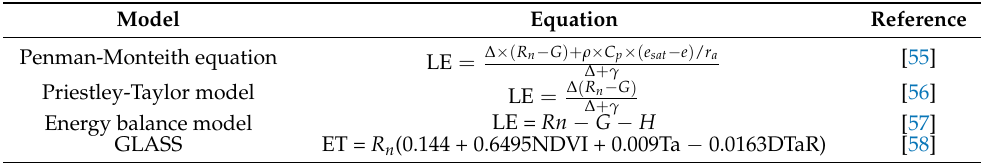
Table 3. Typical process-based models of ET